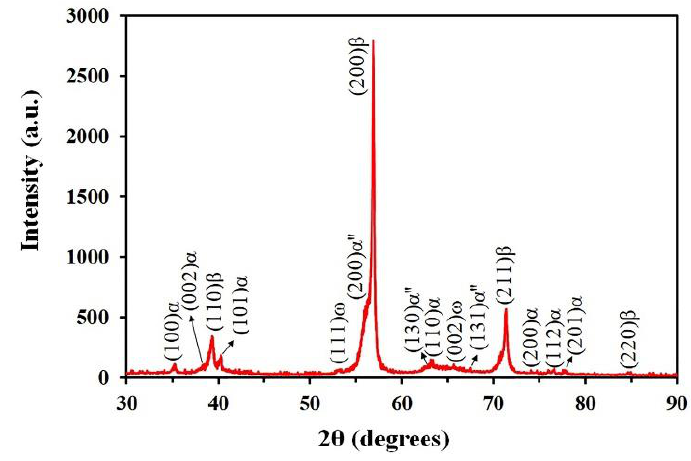
Figure 4. XRD profile obtained from Ti-10-3-3 alloy deformed at 725 ◦ C followed by water quenching to room temperature.